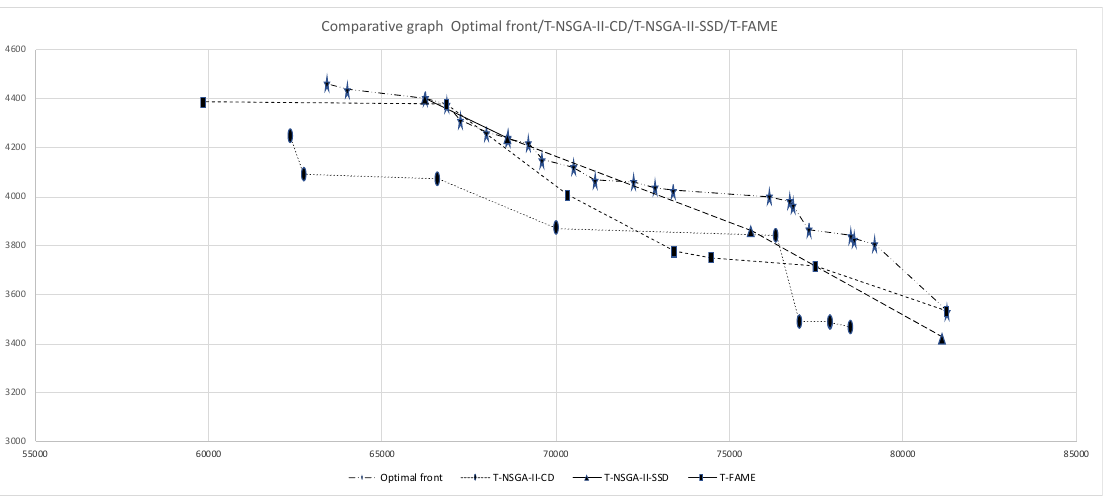
Figure 8. Generated fronts of the algorithms with instance o2p25_rand.